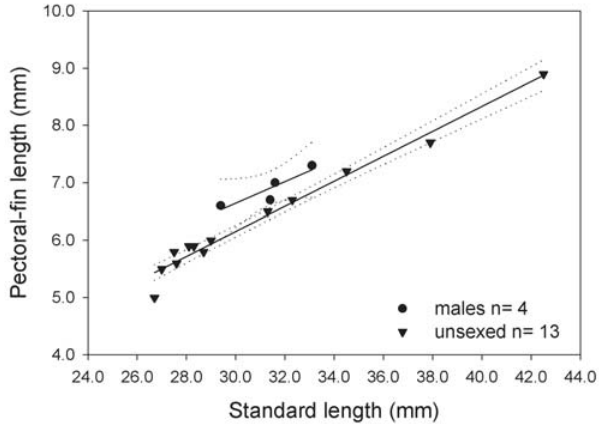
Fig. 23. Pectoral-fin length as a function of standard length for males versus unsexed specimens of Odontostilbe nareuda